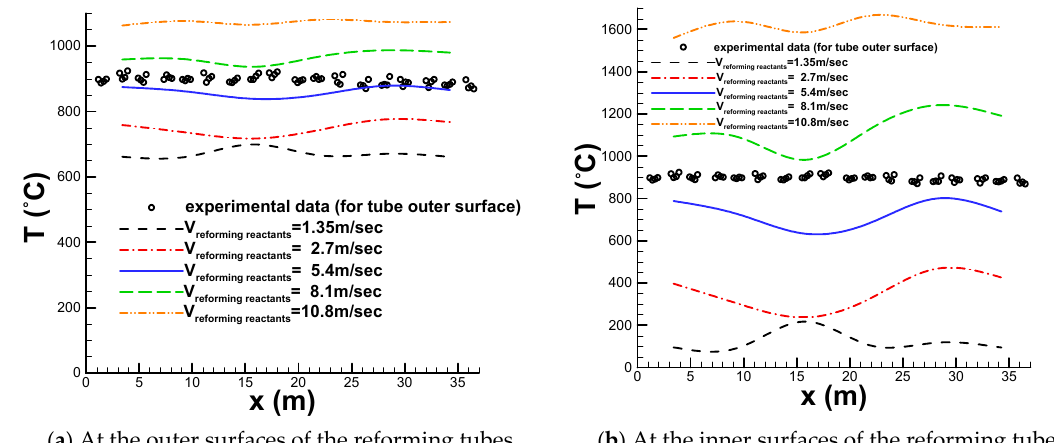
Figure 8. Comparison of the average temperatures at the surfaces of the reforming tubes using different inlet velocities of the reforming reactants.